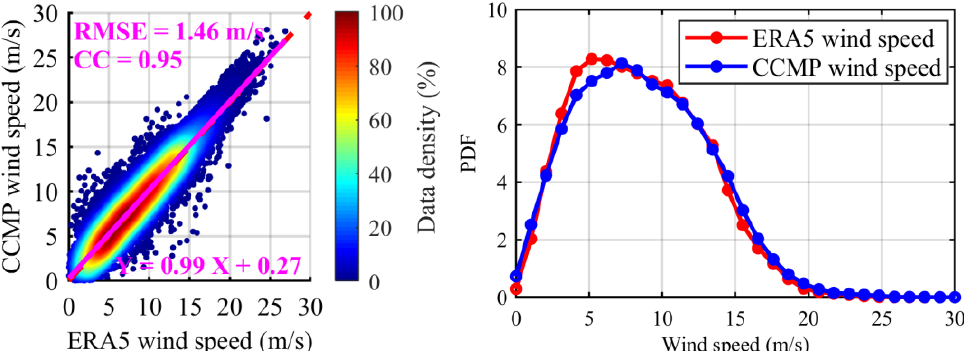
Figure 9. Scatter density plots of ERA5 and CCMP wind speed ( left ) and probability density function (PDF) distribution using ERA5 (the red line) and CCMP (the blue line) products as reference in the testing set ( right ).